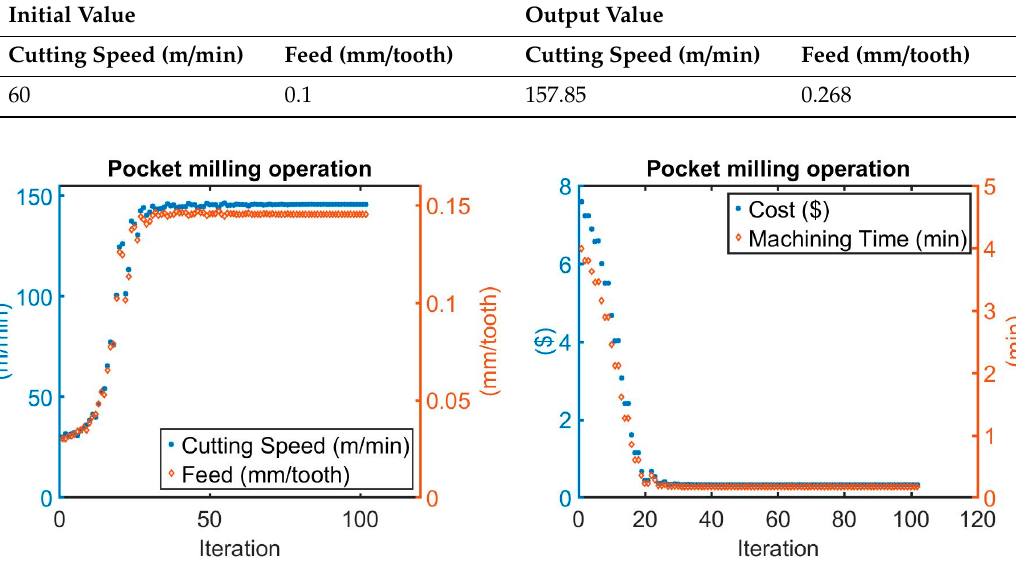
Figure 8. Machining parameters ( left ) and results ( right ) for the pocket operation of the case study. Table 7. Initial and optimum parameters of pocket milling.